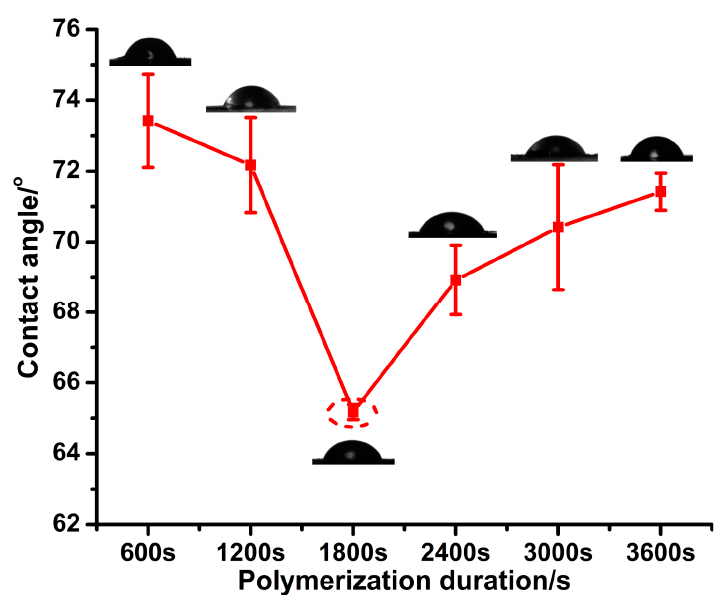
Figure 4. E ff ect of the polymerization duration on the CA values of the PPy(NO 3 − )-ISMs. Figure 4. Effect of the polymerization duration on the CA values of the PPy(NO 3 − )-ISMs.